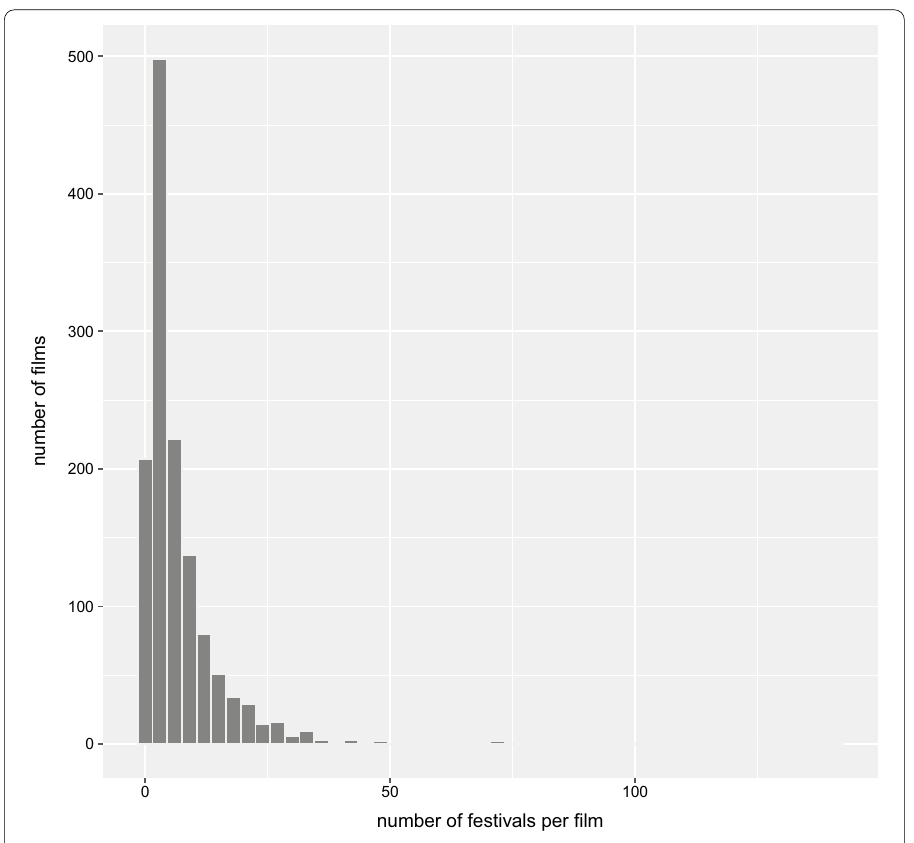
Fig. 7 Distribution of the number of festivals per